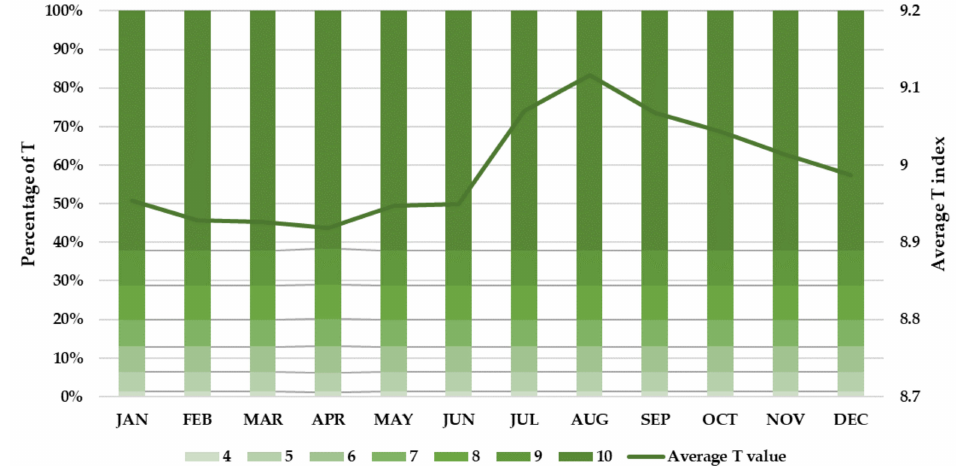
Figure 11. Distribution of the dynamic parameter’s rating for saturated thickness of aquifer